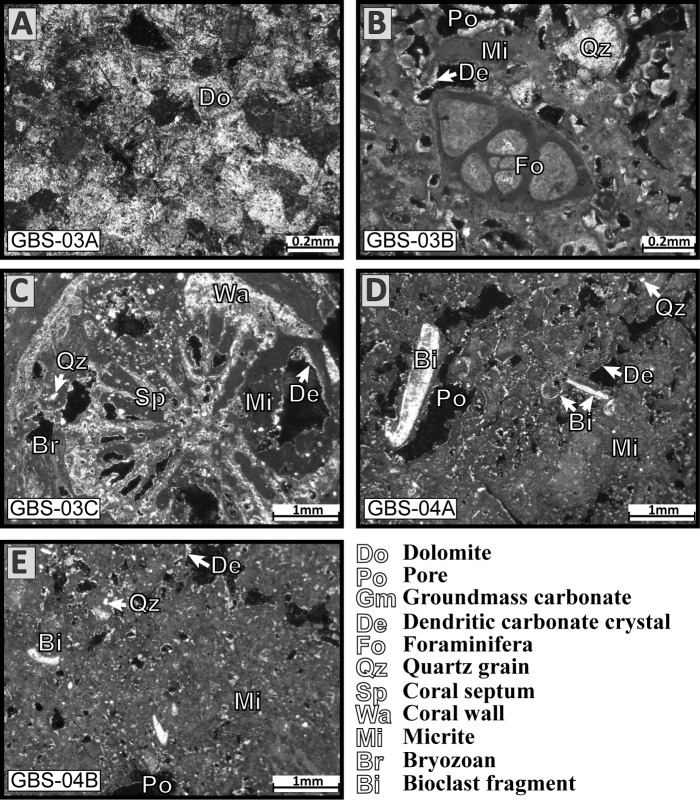
Thin section images of carbonate nodules.(A) Dolomite nodule from station GBS-03. (B) Nodule from station GBS-03 with bioclasts (foraminifera), quartz grains embedded in micrite. (C) Nodule from station GBS-03 with coral fragments and micrite. (D) Nodule from station GBS-04 with bioclasts, quartz grains into micrite. (E) Nodule from station GBS-04 with bioclasts, quartz grains embedded in micrite.